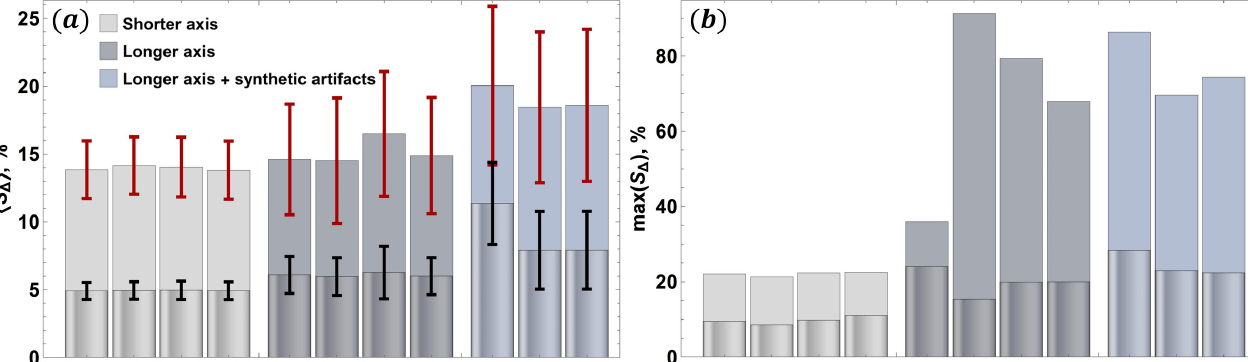
Figure 30. ( a ) Mean and ( b ) maximum S ∆ values for the cases with a moving reference body. The results for the global and local filtering are represented with matte and glossy bars, respectively. The standard deviations for the mean values in ( a ) are indicated by the red (global) and black (local) error bars. Note the color legend in the upper-left corner of ( a ) indicating the three different test groups considered in Figures 28 and